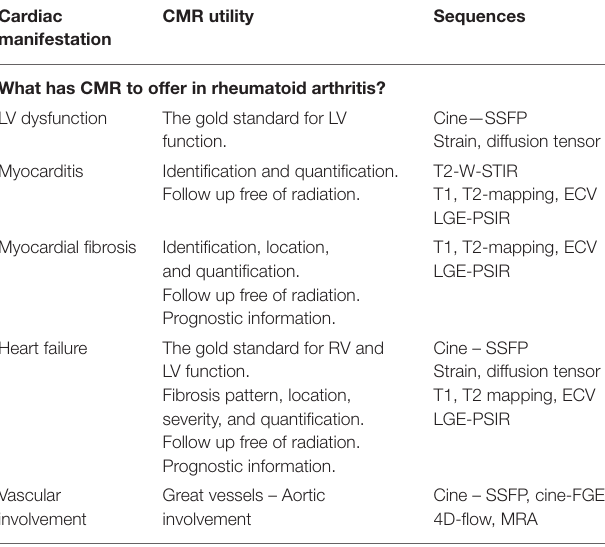
TABLE 4 | CMR offerings to the RA. Cardiac CMR utility manifestation